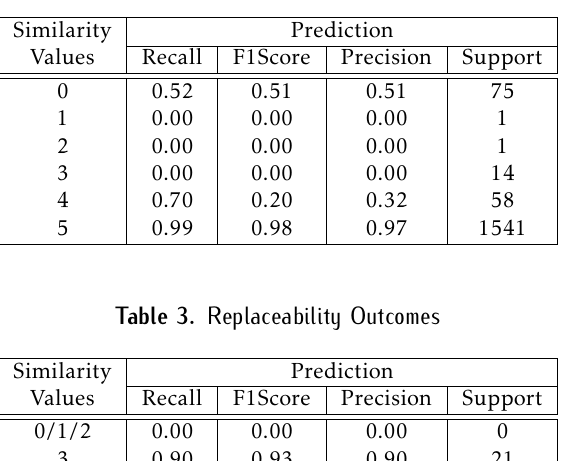
Table 2. Transitivity Test Results based on Convolution Neural Networks